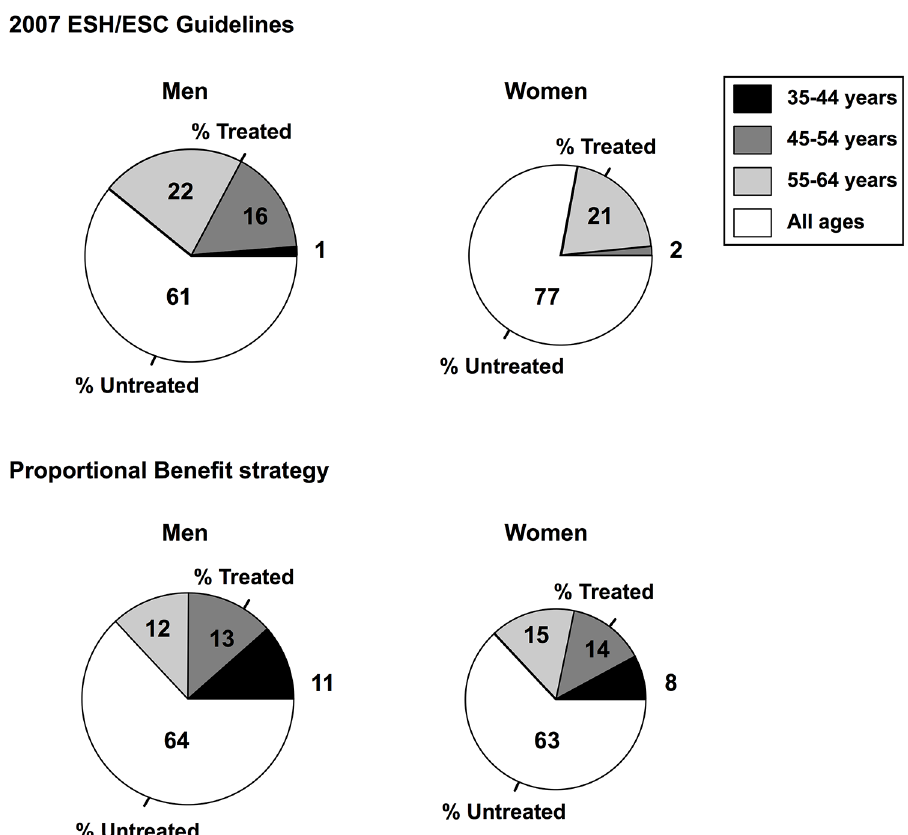
Fig 3. Age-related proportions of individuals to treat according to the PB strategy and the 2007 ESH/ ESC guidelines. Pie areas indicate the relative contributions of age classes to the overall number of subjects eligible to treatment referred to the ineligible individuals of all